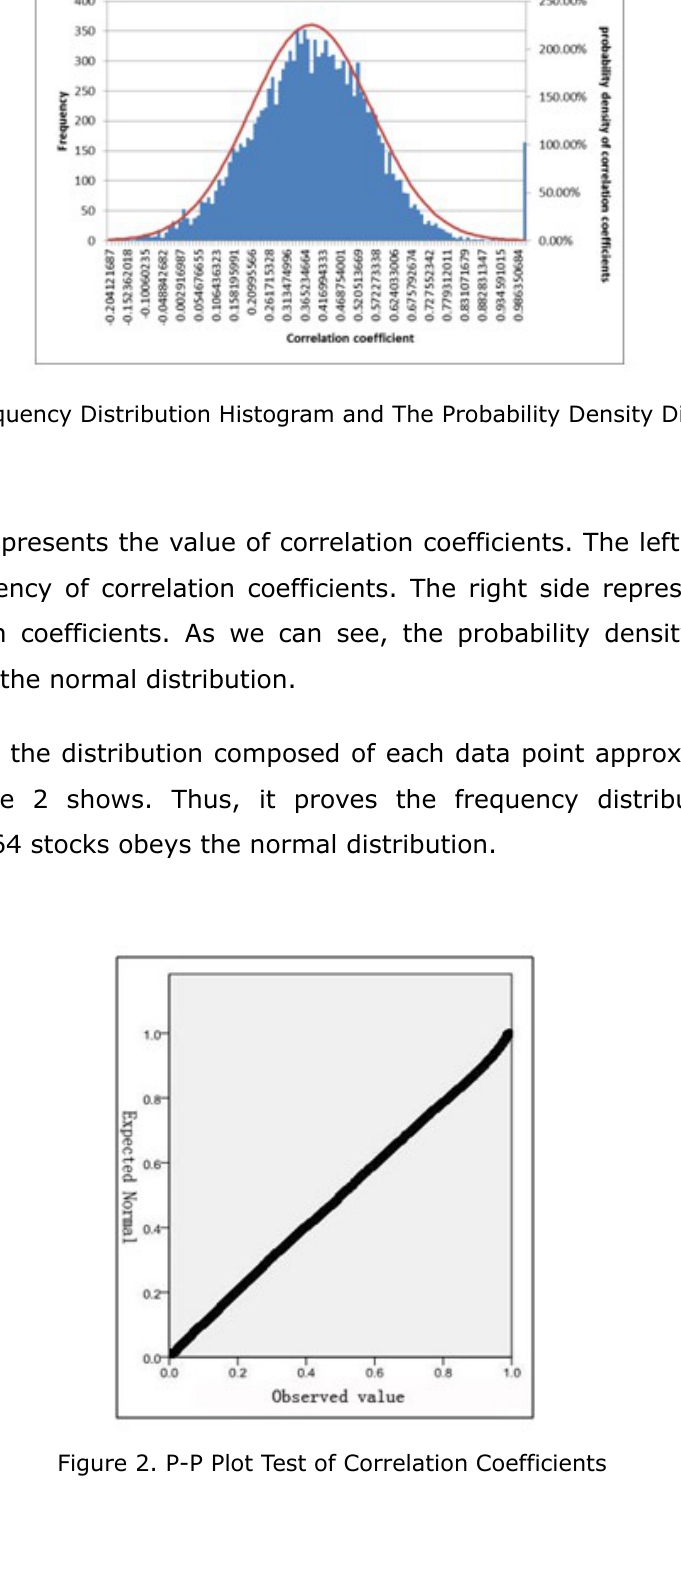
Figure 2. P-P Plot Test of Correlation